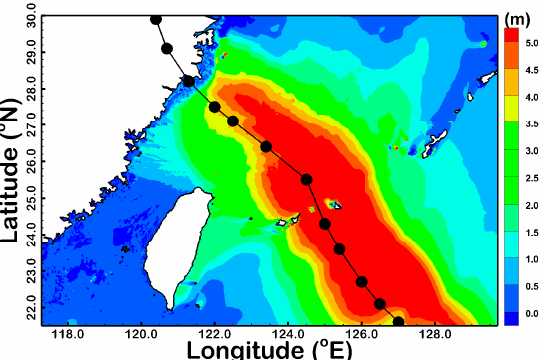
Figure 7. Spatial distribution of the difference in maximum SWH using the winds from H_4R max and the original ERA5 during the passage of Super Typhoon Lekima in 2019.